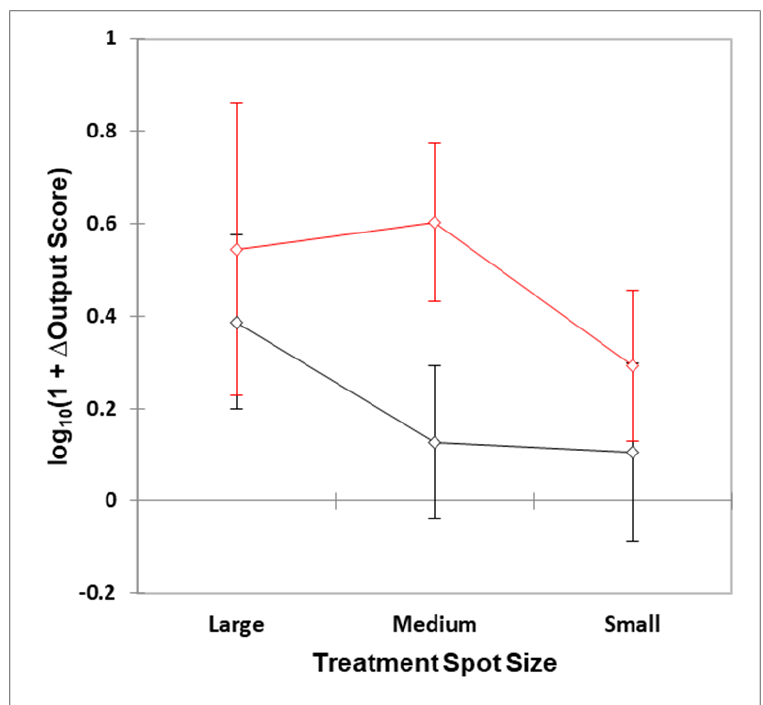
Figure 2. Plots of mean ± 95% confidence intervals for the large, medium and small spot size treaments at both deep (black) and superficial (red) target sites. ∆ Output Score represents differences determined between the mean clinical outcome score variables observed for the laser and control treatment groups, which was positive for all 38 studies reported.